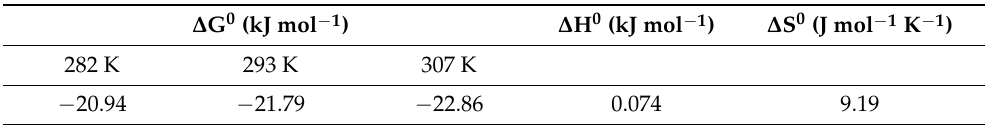
Table 4. The thermodynamic parameters for crystal violet adsorption on adsorbents obtained from motherwort